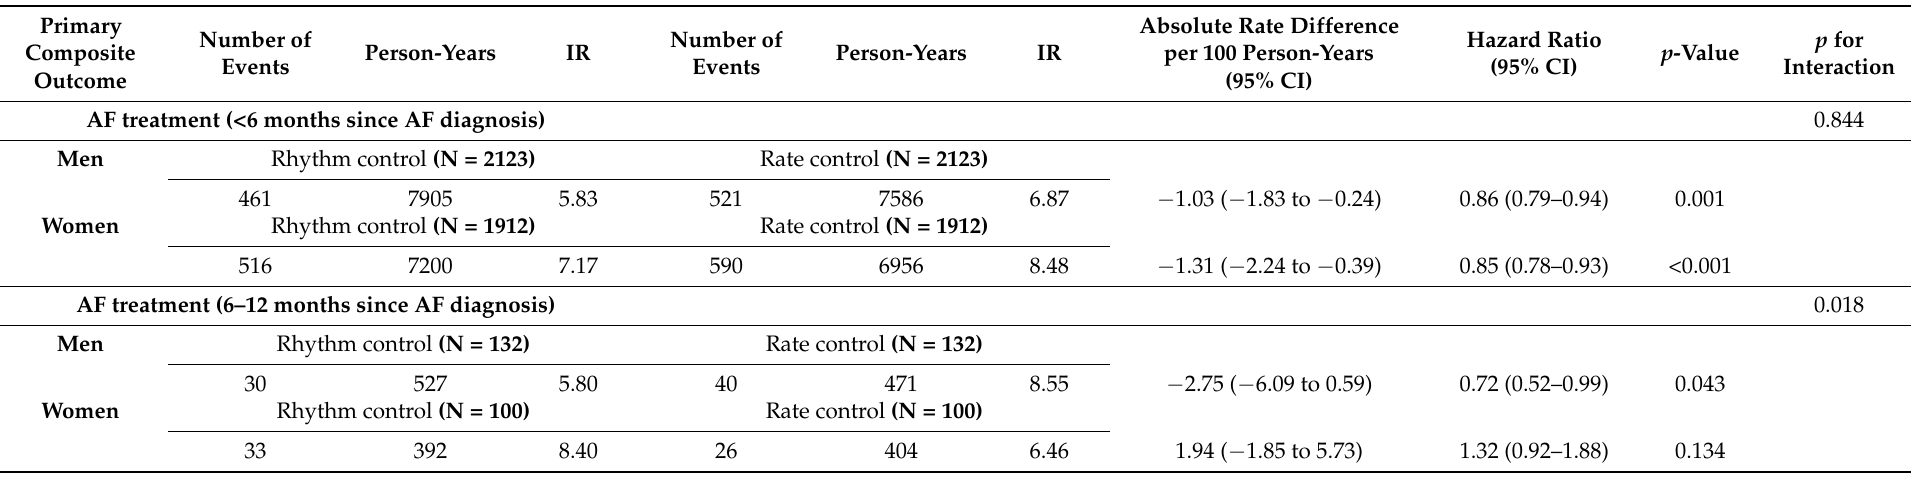
Table 3. Relative effect of rhythm control over rate control on primary composite outcome after overlap